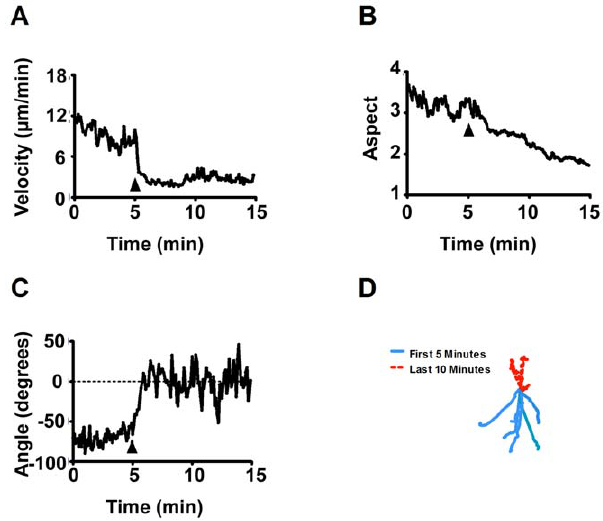
Figure 5. Analysis of Dictyostelium cell behaviour with addition of 5 mM denatonium benzoate after 5 Min. Mean data repre- senting 89 cells chemotaxis over a 15 min period following addition of denatonium benzoate (5 mM) at 5 min (arrow) for A: cell velocity; B: cell aspect; C: cell angular movement; D: cell tracking (where the co- ordinates of individual cells were illustrated following normalisation to (0,0) at 5 min, represented by single lines for 0–5 min (blue) or 5– 15 min (dashed red) and cell direction has been adjusted so that cells are moving up the page). Data from A–C is presented as a mean of triplicate experiments analysing approximately 30 cells in